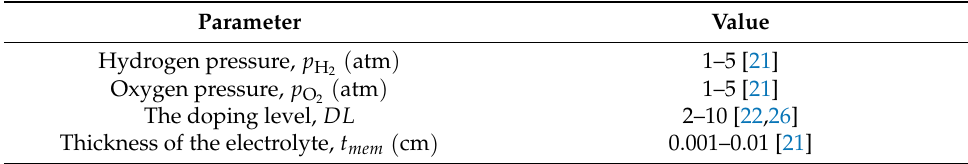
Table 2. Variation ranges of p , DL and t mem .